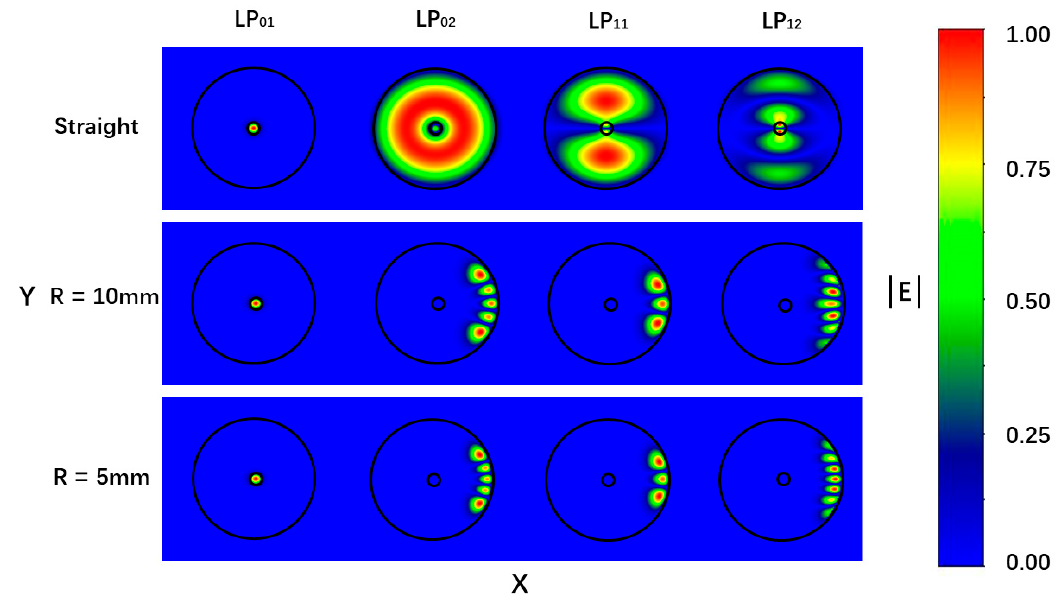
Figure 3. Mode fields of the first two orders of the LP 0n and LP 1n for the straight fiber and bending fibers with the bending radius of 10 and 5 mm, respectively.